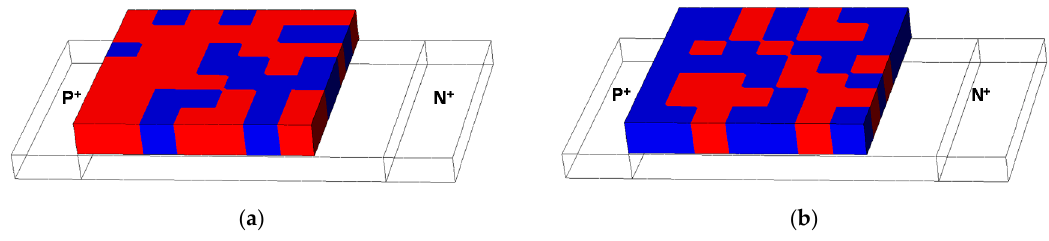
Figure 3. Metal grain distributions of planar TFETs in extreme cases (red color: metal grains with a work-function (WF) of 4.6 eV, and blue color: metal grains with a WF of 4.4 eV) among the simulated samples. ( a ) Maximum V turn-on (0.367 V) case of planar TFETs. ( b ) Minimum V turn-on (0.289 V) case of